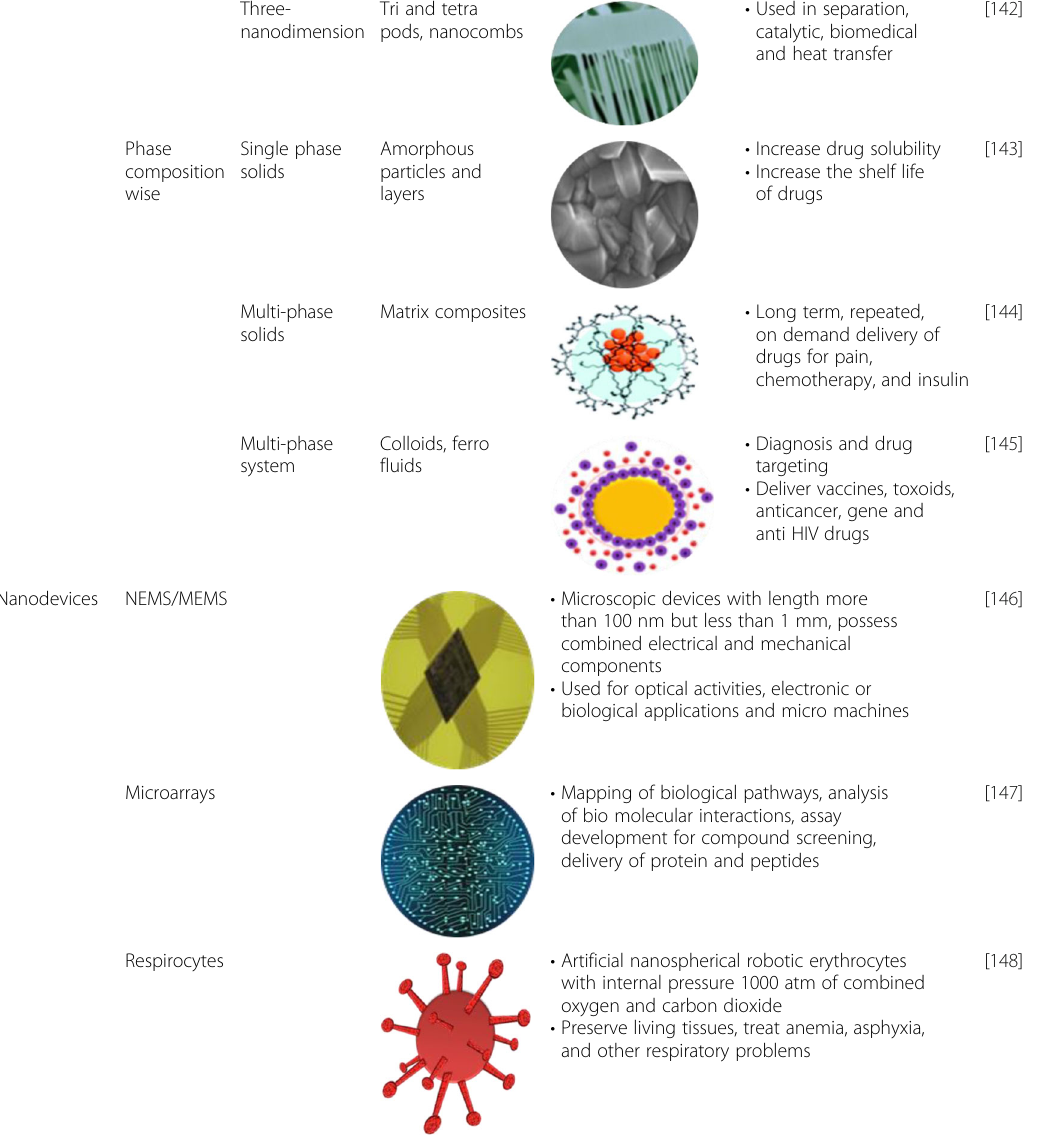
(cid:129) Used in separation, catalytic,